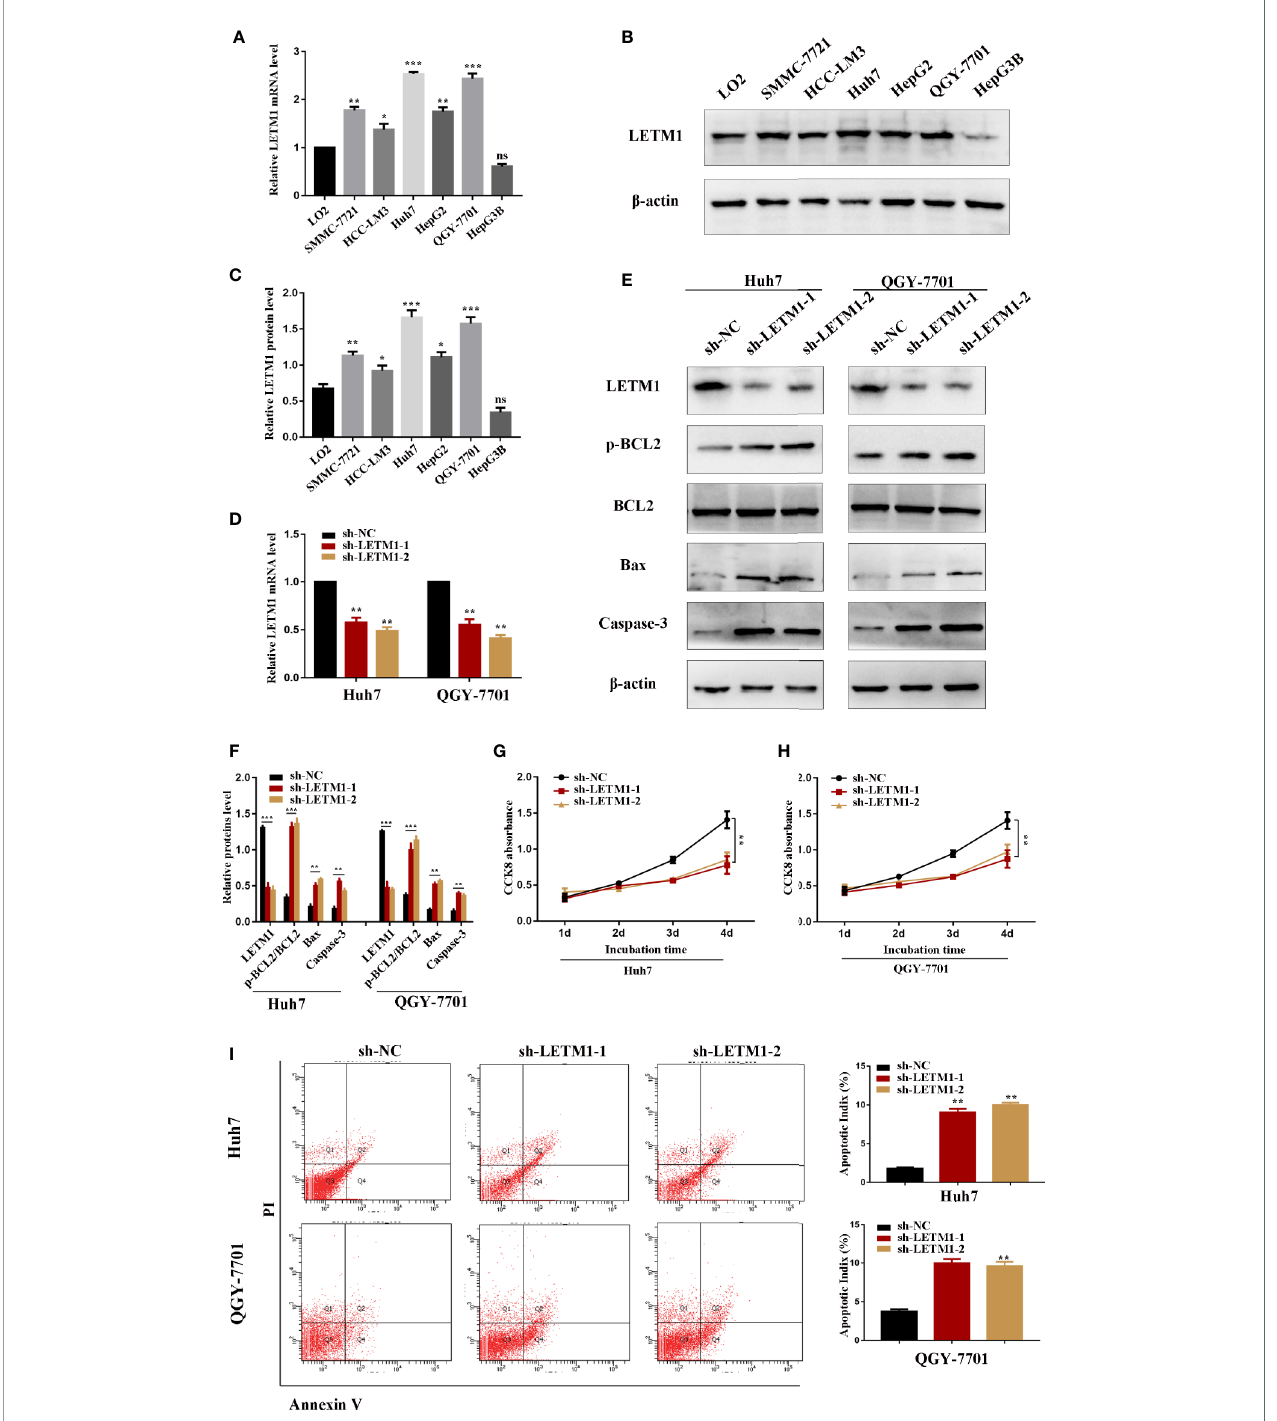
FIGURE 2 | Knockdown of LETM1 inhibits cell proliferation and promotes apoptosis in hepatocellular carcinoma (HCC) cell lines. (A) RT-qPCR analysis of LETM1 expression in LO2 and HCC cell lines. (B, C) Western blotting of LETM1 expression in LO2 and HCC cell lines. (D) RT-qPCR analysis to estimate the transfection effect of LETM1 shRNA lentivirus. (E, F) Western blotting of LETM1 and apoptotic-related proteins (p-Bcl-2, Bcl-2, Bax, caspase-3) in Huh7 and QGY-7701 cell lines. (G, H) CCK8 assays to detect the growth rate of LEMT1 knockdown in Huh7 and QGY-7701 cell lines. (I) Flow cytometry to test the apoptotic index in LETM1-knockdown Huh7 and QGY-7701 cells. * p < 0.05, ** p < 0.01, *** p < 0.001 versus sh-NC group. ns, no signi fi